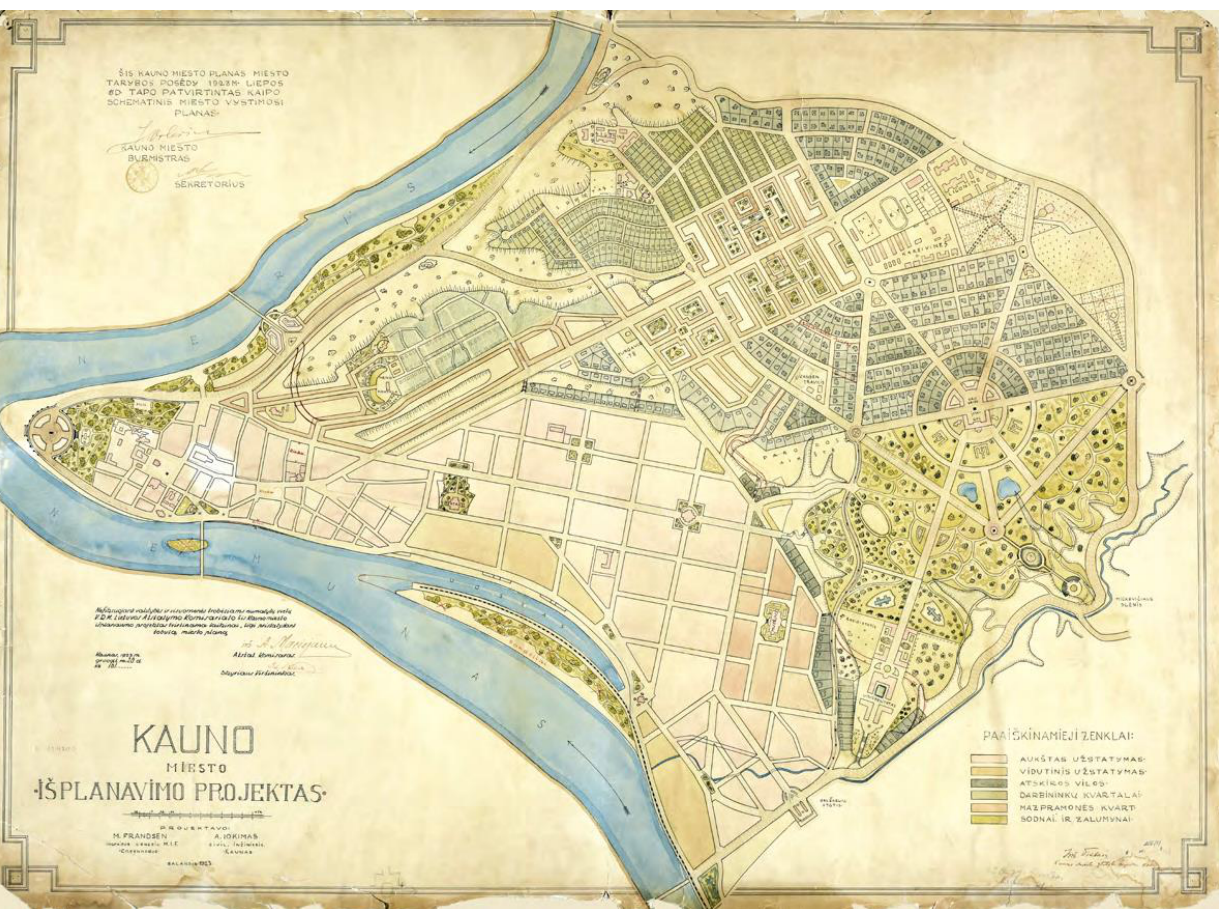
Figure 3. A Master plan for Kaunas by engineers Marius Frandsen (Copenhagen) and Antanas Jokimas (Kaunas), 1923. Drawing source: Lithuanian National Museum (published with permission).